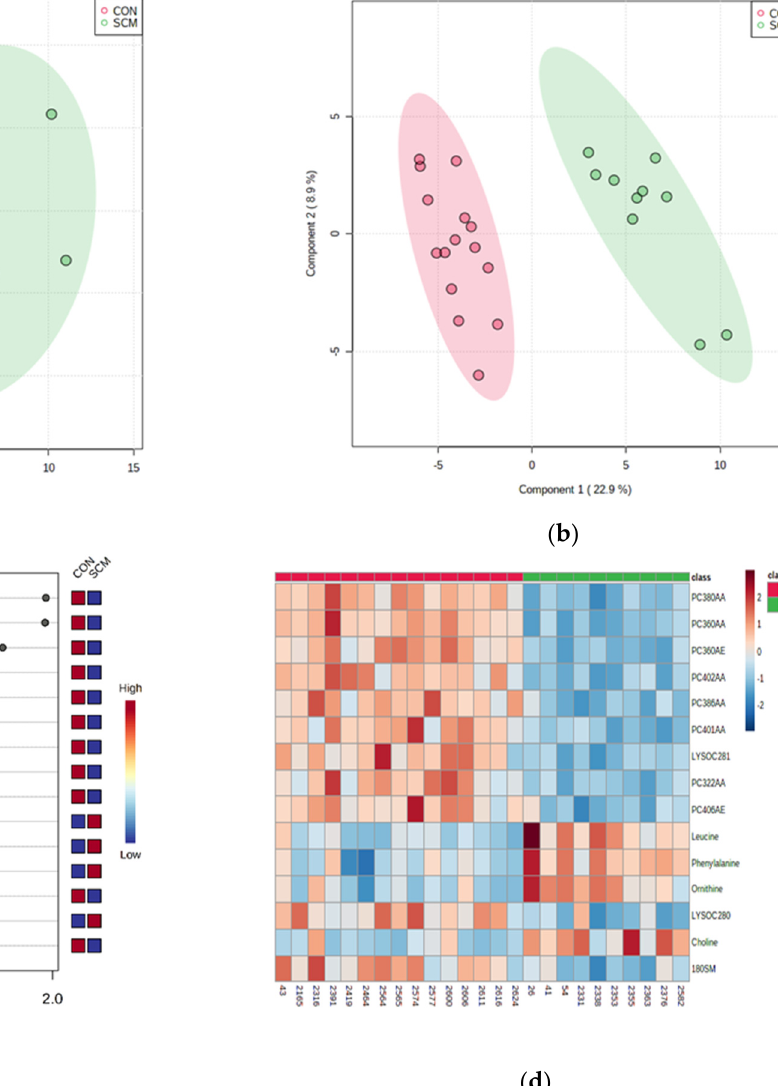
Figure 1. ( a ) Principal component analysis (PCA) and ( b ) partial least square—discriminant analysis (PLS-DA; permutation test: p < 0.05 ) showing two separate clusters for CON and pre-SCM cows at − 8 weeks before parturition; ( c ) metabolites ranked by variable importance in projection (VIP) and ( d ) heatmap of both samples and features based on PLS-DA to further investigate the identified variables.